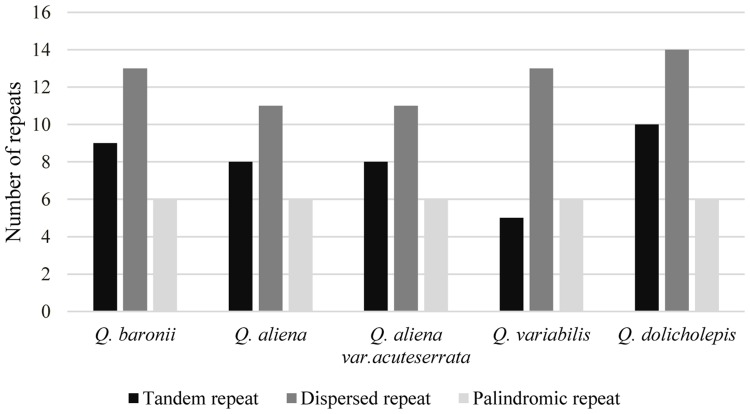
Repeat number. Histogram showing the number of three repeat types in five Quercus complete cp genomes.